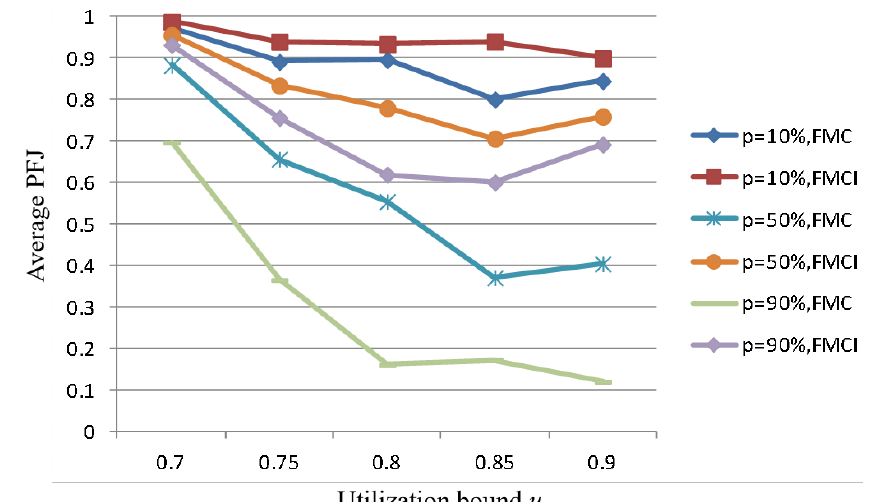
Figure 5. Comparison of scheduling results between FMCI and